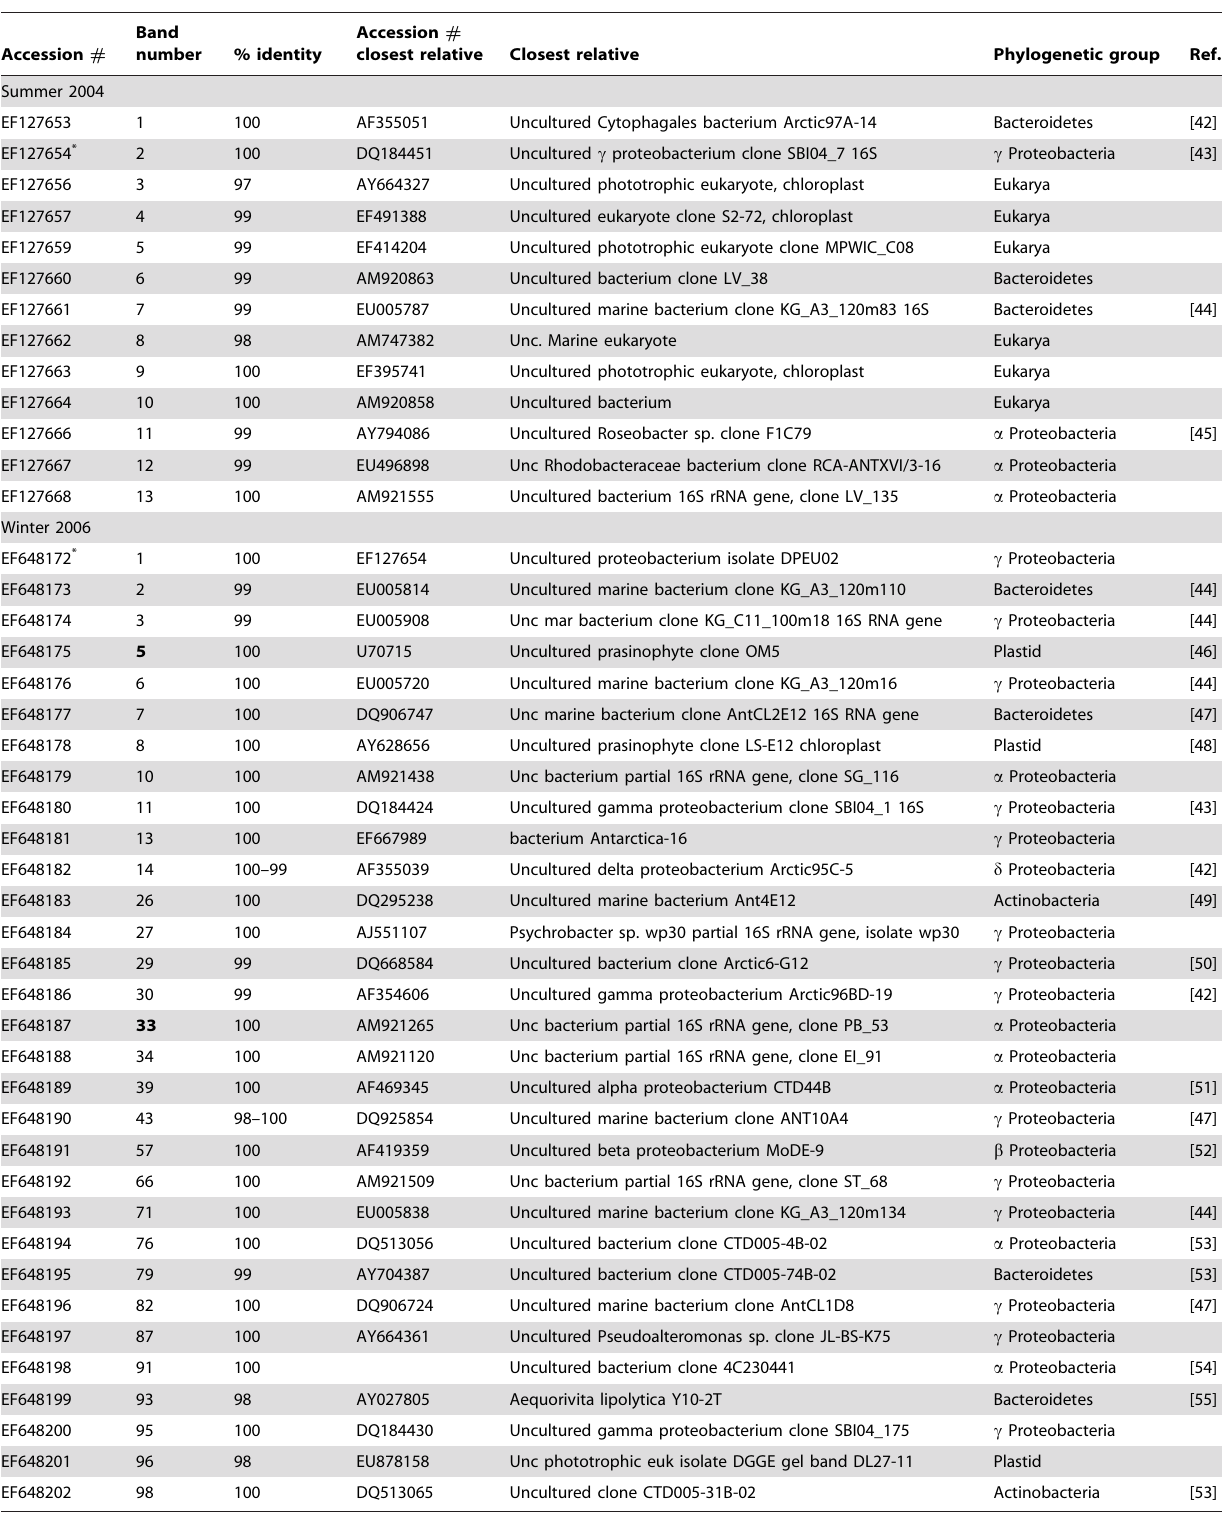
Table 2. List of GenBank accession number and closest relative to 16S rDNA bacterial sequences obtained from DGGE.